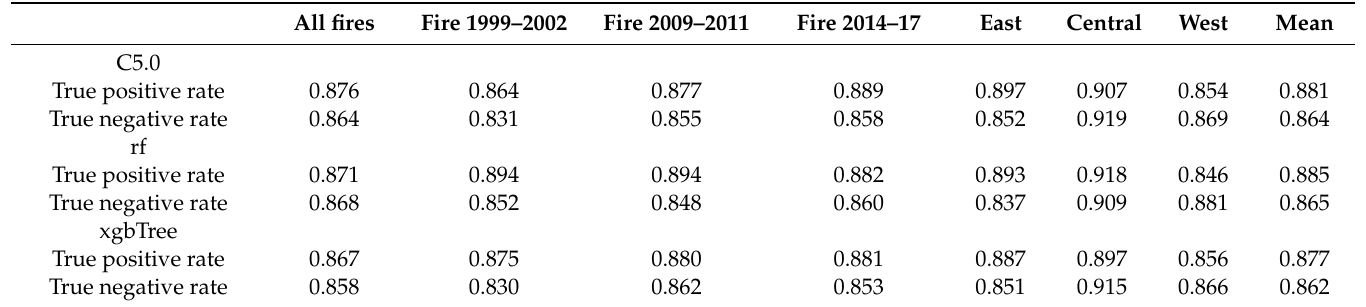
Table 3. True positive rate and true negative rate of predictions for three di ff erent classifiers (C5.0; rf = random forests, xgbTree = extreme gradient boosting with trees) for test set (25% of observations) based on modeled training data of all fire occurrences during 1999 to 2017, 1999 to 2002, 2009 to 2011, 2014 to 2017, and three